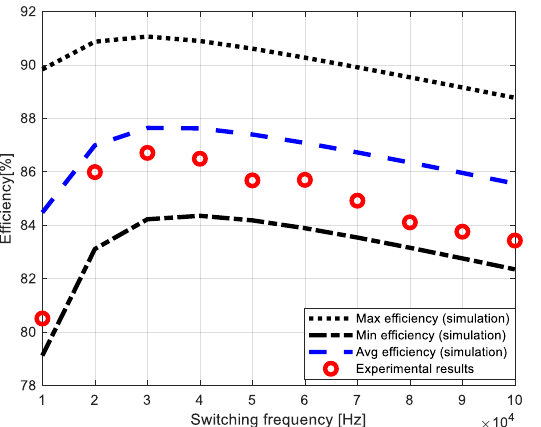
Figure 8. Comparison of simulation and experimental results for the push – pull converter efficiency with input power of 500 W.